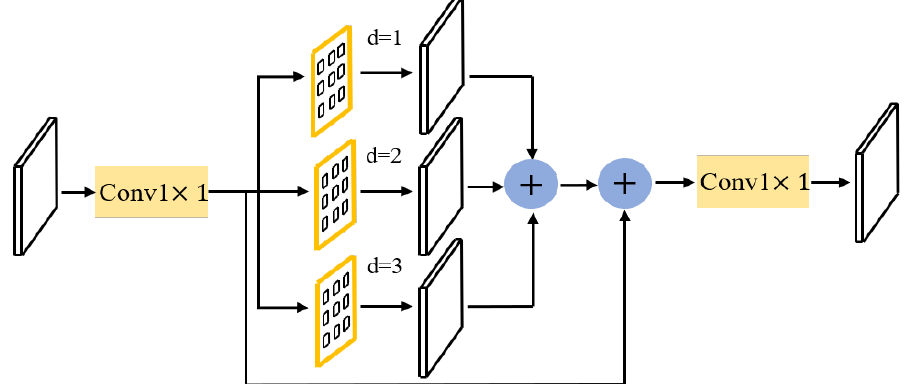
Figure 5. Residual-aware module: to extract varied-scale contextual information, the input features are first compressed by half through a 1 × 1 convolutional channel before being fed into three dilated convolutions (convolutional kernel is 3 × 3, and the dilated rates are 1, 2, and 3). A residual branch is paralleled, keeping the original resolution’s detailed information. These features are fused and then restored to the original channel after 1 × 1